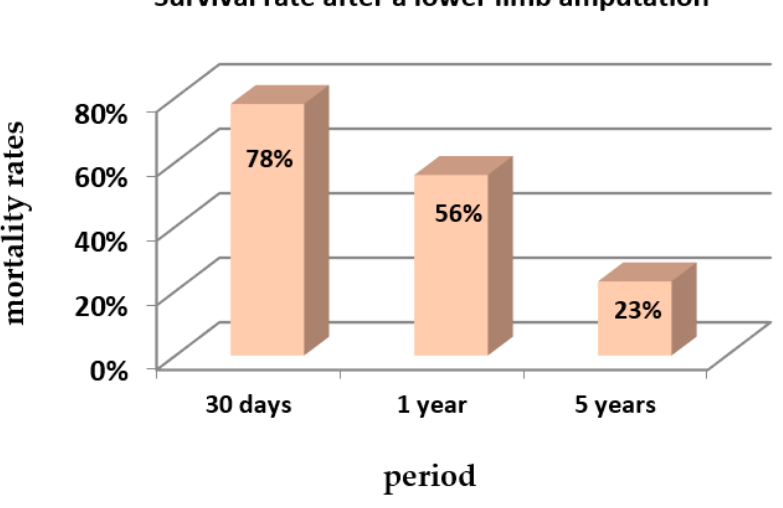
Figure 3. Mortality rates after a first lower limb amputation (%) in a period of 5 years—retrospective cohort study. Source: Fortington et al., 2013 [14].